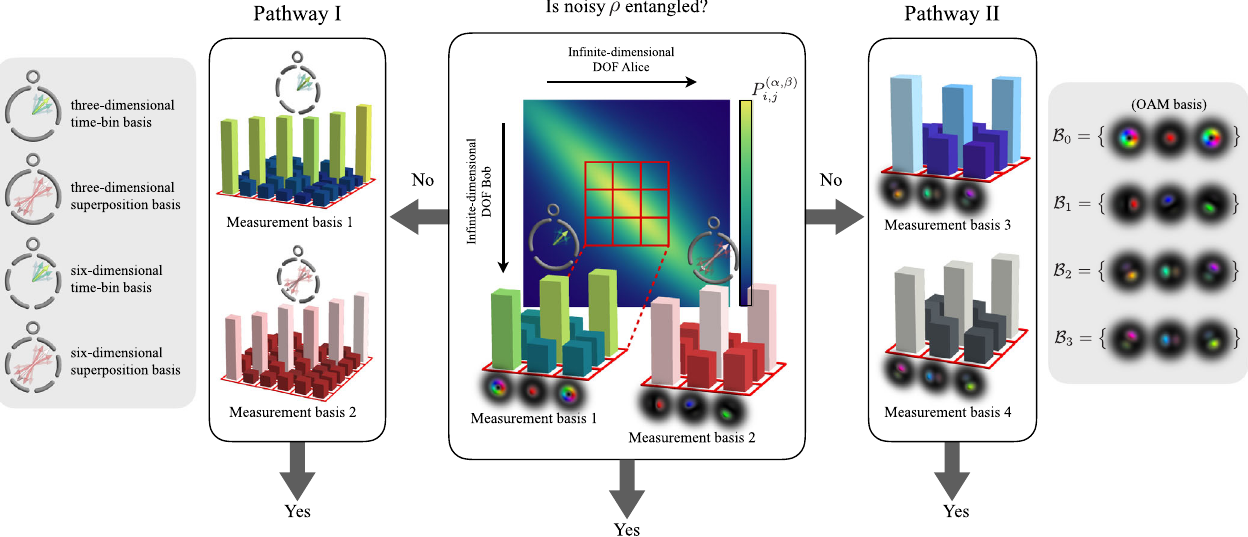
FIG. 1. Illustration of the pathways to noise resilience. A mixed entangled state ρ shared by Alice and Bob is encoded in spatiotemporal properties of photon pairs. Each of the infinite-dimensional d.o.f. of the photons can be discretized and measured in two bases (center panel). If both measurements are insufficient to certify entanglement in the noisy state, there are two pathways to recover it: fine-graining to higher dimensions (pathway I, left-hand panel) and measuring in additional bases (pathway II, right-hand panel). In pathway I, noise is “ diluted ” by discretizing the existing state space further, resulting in an increased signal-to-noise ratio. Pathway II exploits the existence of more than two mutually unbiased measurement bases in higher dimensions, providing additional information α ; β Þ ’ s modes i in the basis α and about the nonclassicality of the state. The bar charts illustrate the joint probability P ð i;j of measuring Alice Bob ’ s modes j in the basis β